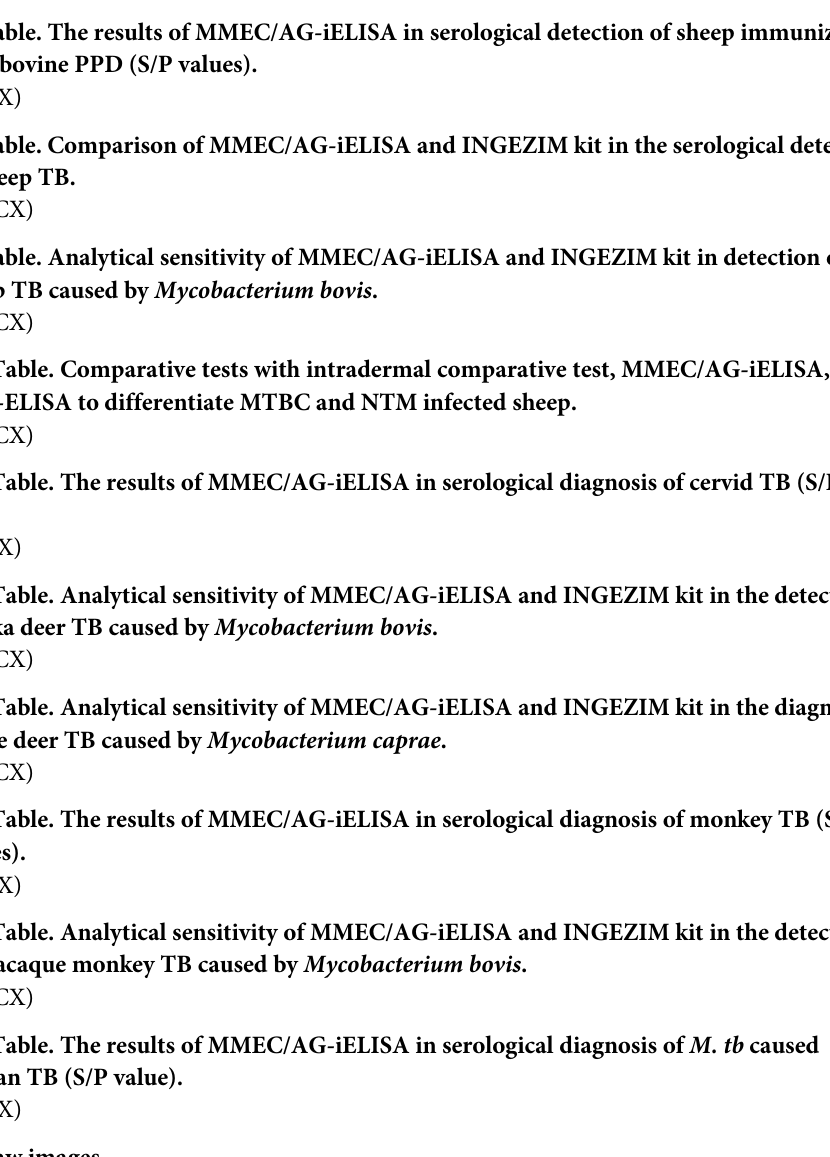
S7 Table. The results of MMEC/AG-iELISA in serological detection of sheep immunized